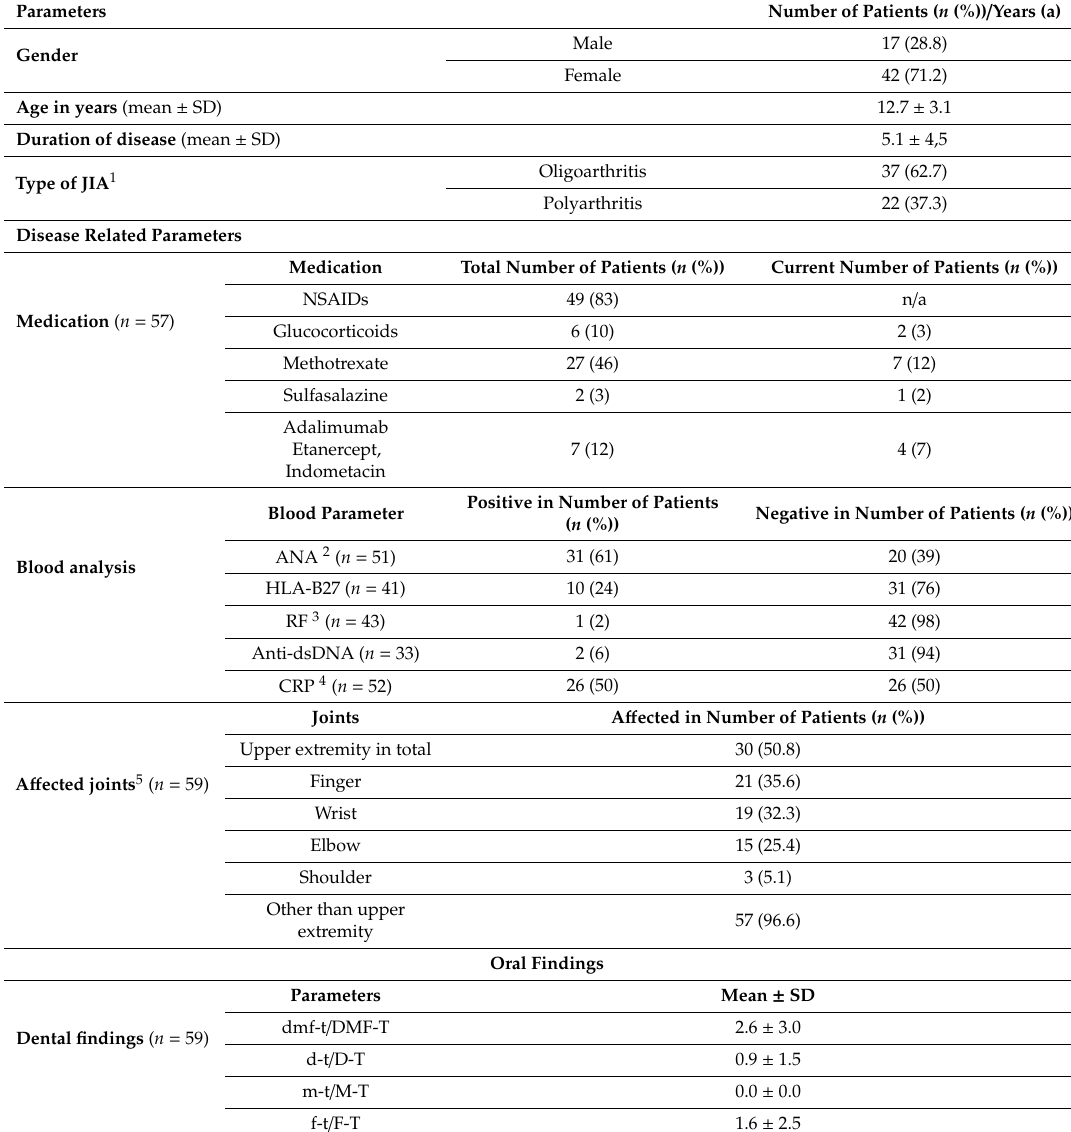
Table 1. Characteristics of study participants ( n = 59) including disease related parameters and oral